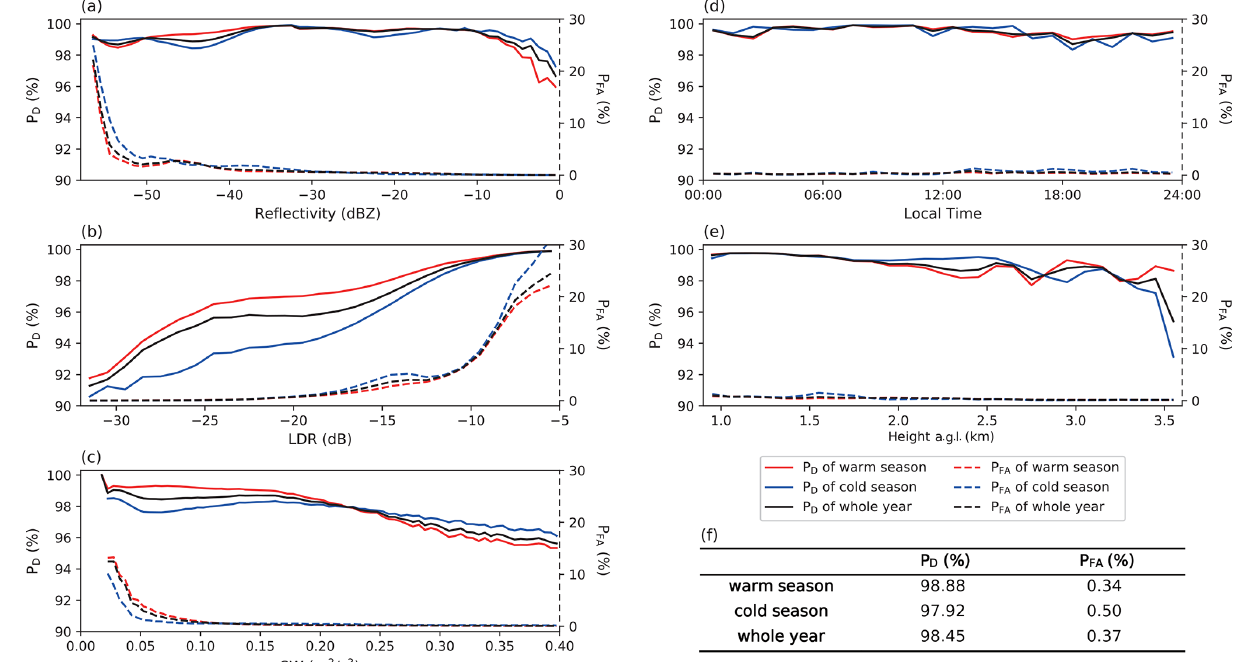
Figure 14. Probability of detection ( P D , solid line) and false alarm rate ( P FA , dashed line) as function of reflectivity (a) , LDR (b) , SW (c) , time (d) , and height (e) for the warm season (red line), cold season (blue line), and whole year (black line). The values of P D and P FA for the warm season, cold season, and whole year are shown in panel (f)